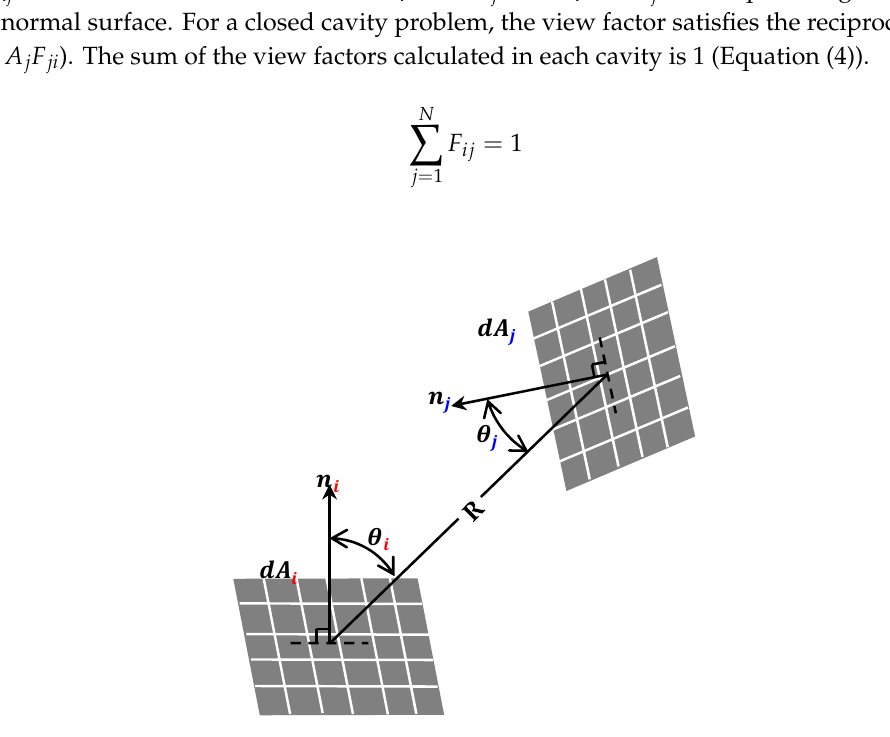
Figure 2. Schematic representation of the view factor.